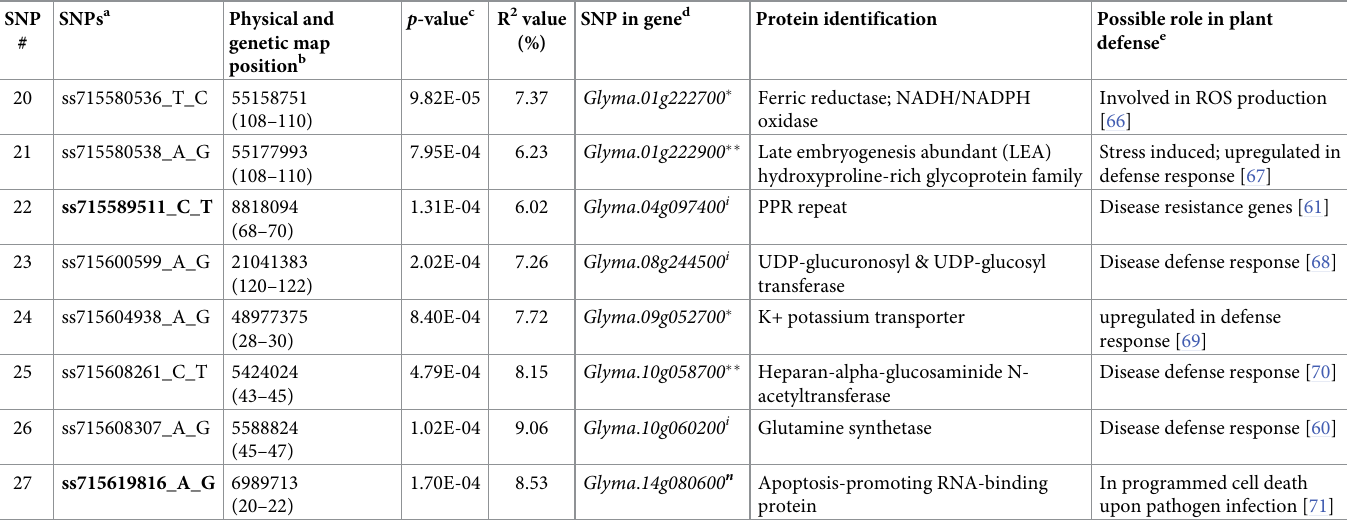
Table 2. Details of eight SNPs that are associated with root rot